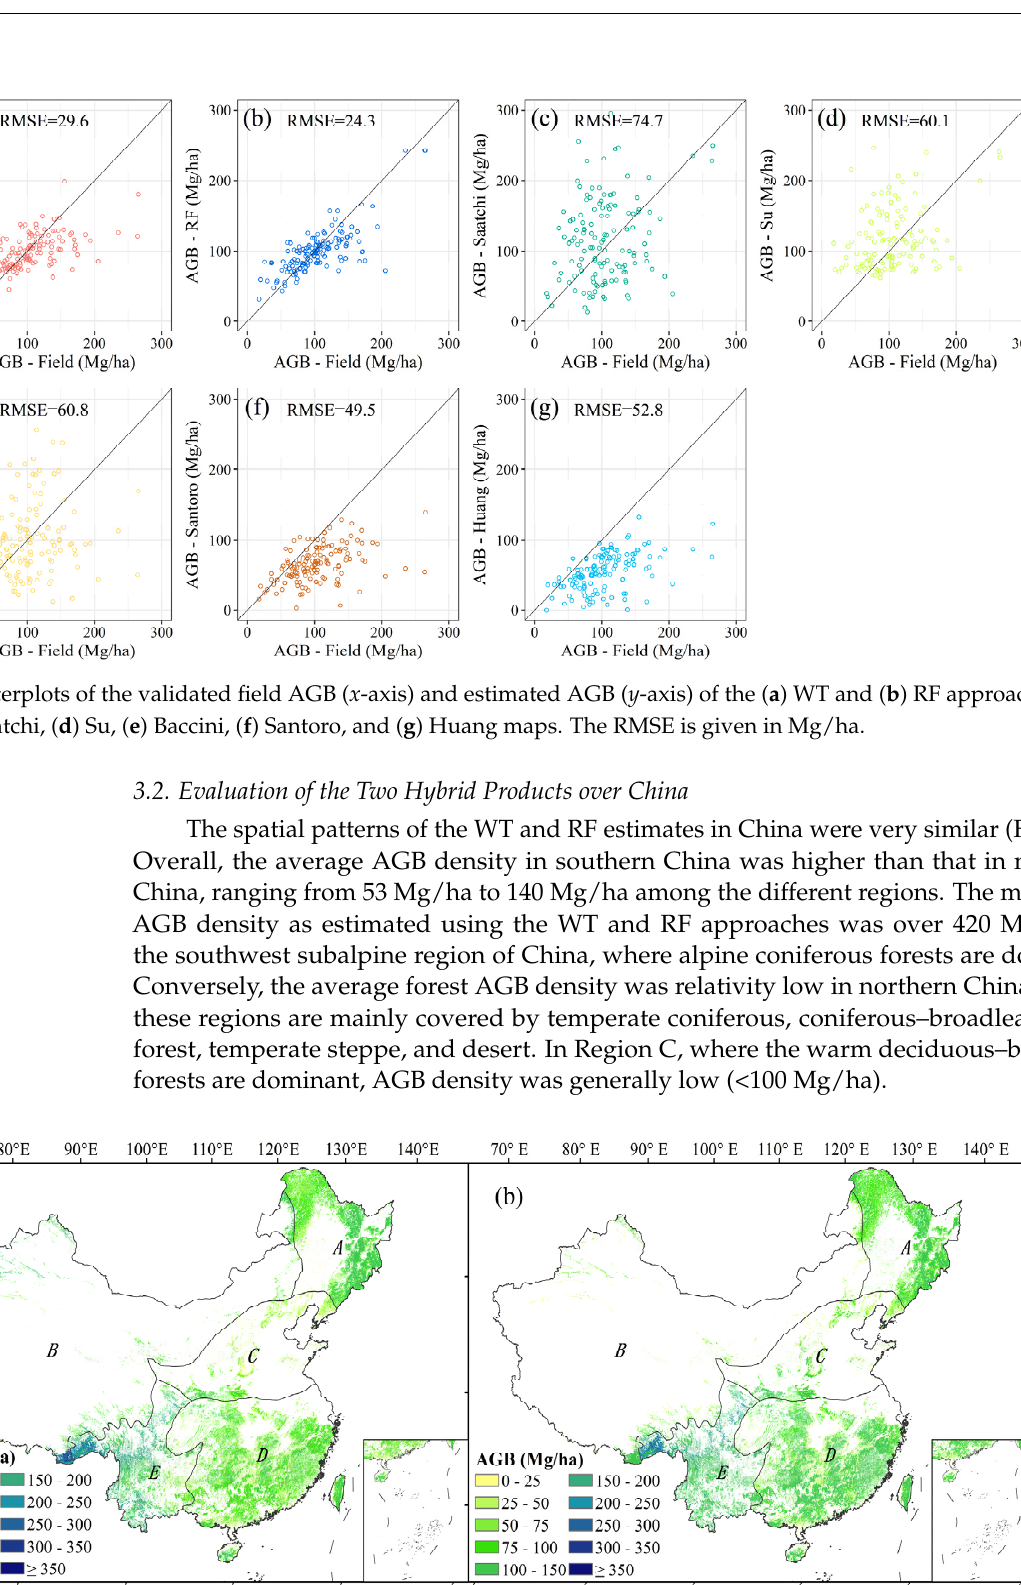
Figure 3. ( a ) RMSE, ( b ) bias, and ( c ) RSD of the hybrid and participating products computed using the out-of-sample test.